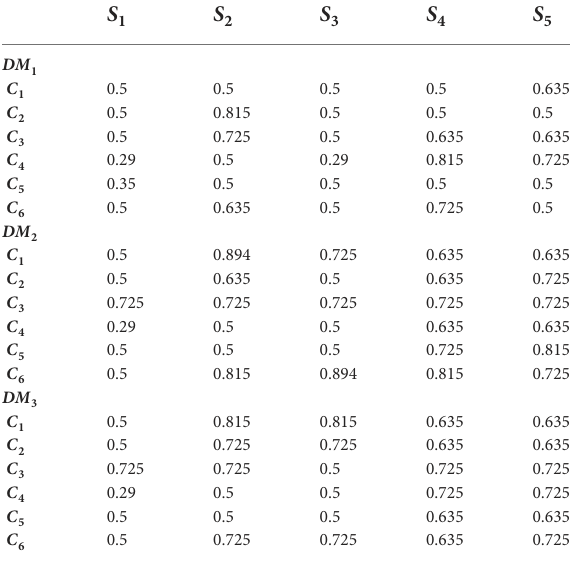
TABLE 5 Integrated Z-number of evaluation of the alternatives under criteria for three decision